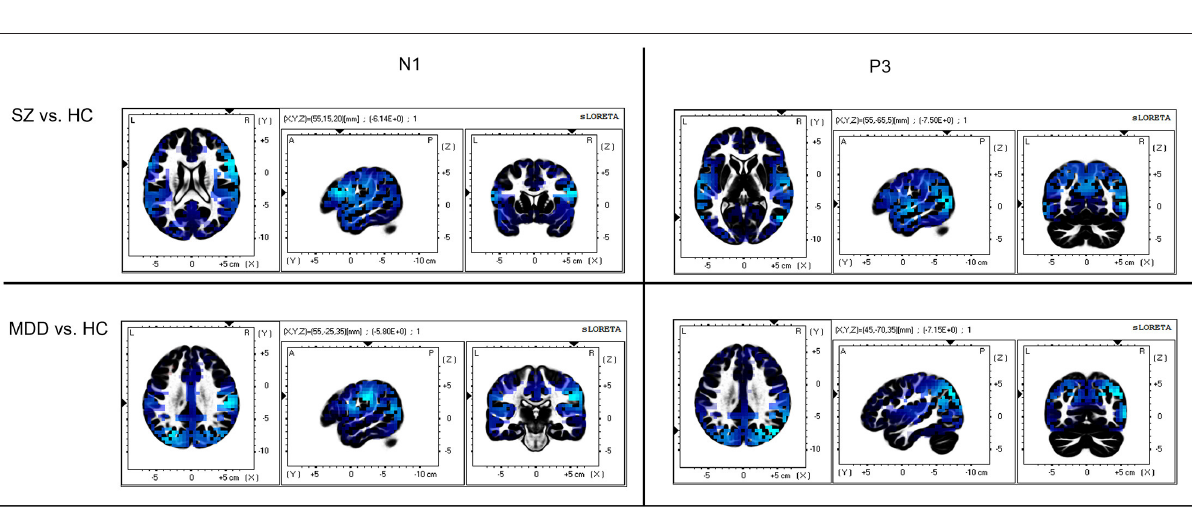
FIGURE 2 | Comparison of AP300 at cortical source level. Blue color indicates cortical source deactivations in patients, compared to healthy controls. The sLORETA has a low-resolution anatomical